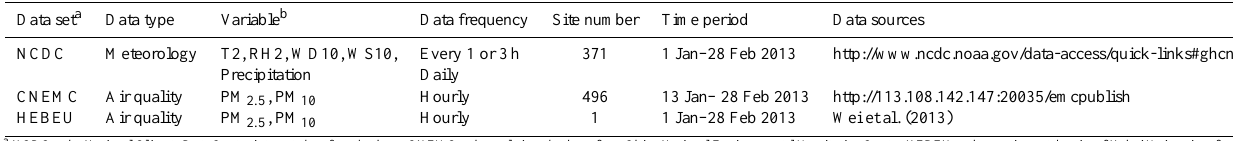
Table 1. Observational data sets for model evaluation used in this